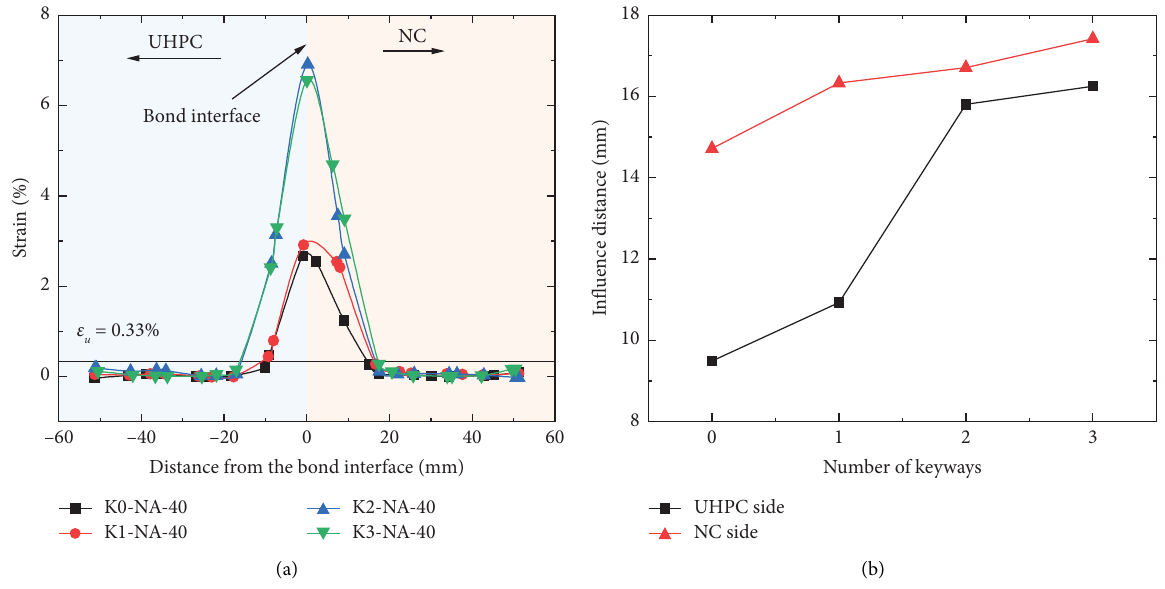
Figure 6: Te range of the strain damage zone. (a) Principal shear strain distribution. (b) Te range of the infuence